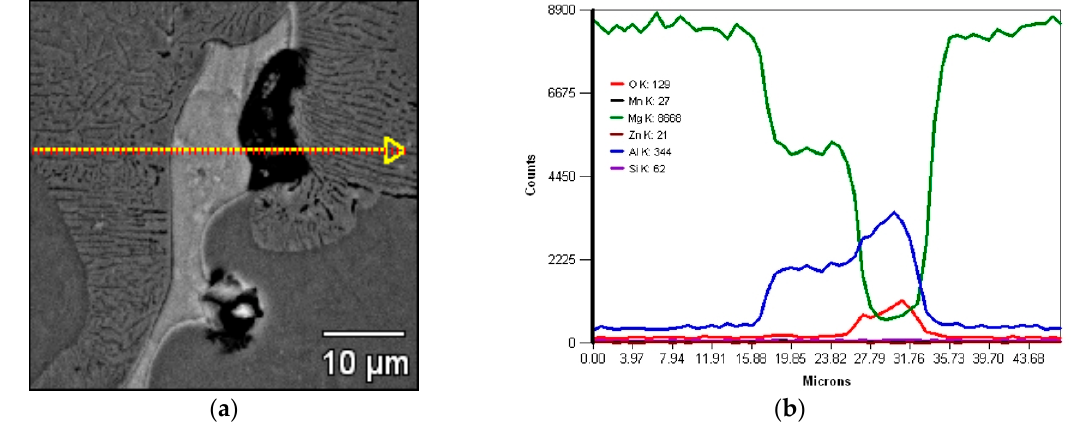
Figure 4. Aluminium oxides in AZ91 alloy overheated at 850 °C: ( a ) SEM, ( b ) line EDS analysis of chemical composition.